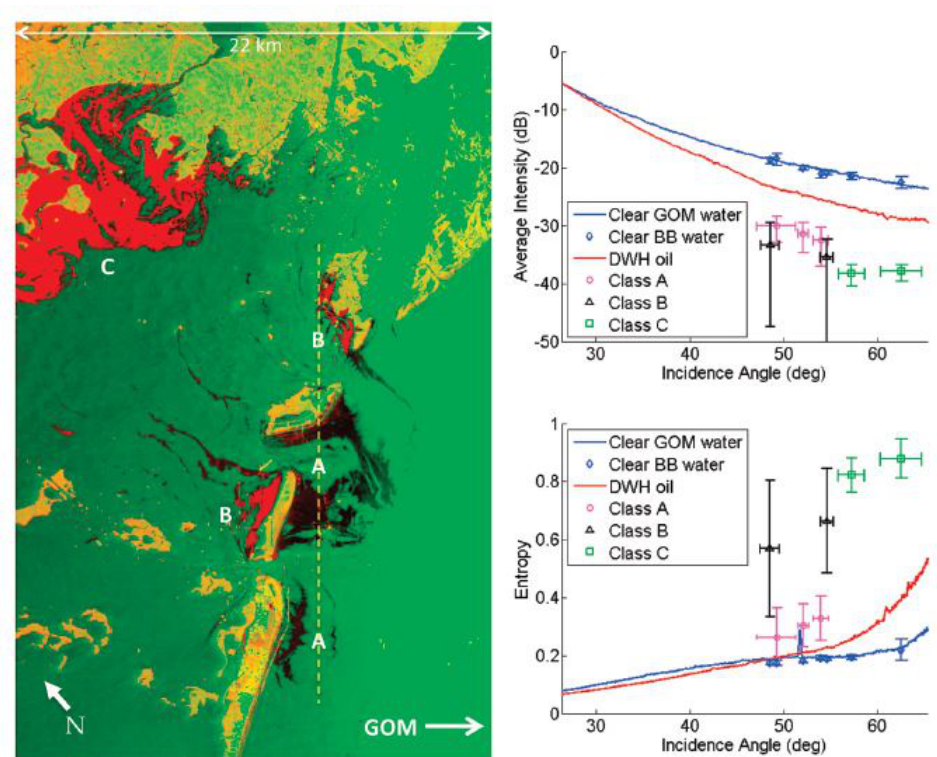
Figure 3. ( left ) Image with combination of Polarimetric features Average Intensity Λ (Red) and En- tropy(Green) divided into 3 classes ( A )-Thick Weathered oil, ( B ) Weathered oil mixed with Sediment near BB coastline and ( C ) Weathered oil heavily mixed with sediment . ( Right ) Λ (top) and entropy (bottom) plotted as a function of incidence angle for clean water in the GOM and in BB, oil in the main slick near the DWH site (DWH oil), and oil classes A, B, and C.